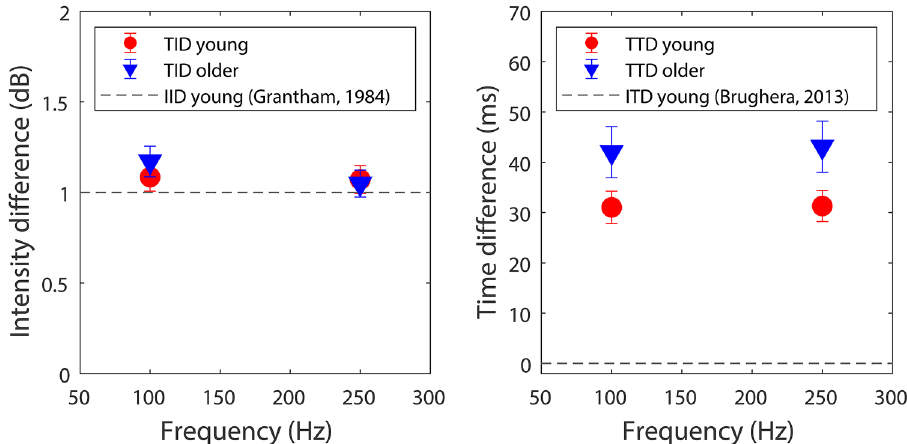
Figure 1. Tactile intensity (TID; left panel) and time (TTD; right panel) difference discrimination thresholds across the wrists for young (red circles) and older (blue downward facing triangles) participants. Thresholds are shown for both 100- and 250-Hz sinusoidal stimuli. For comparison, dashed grey lines show thresholds for interaural intensity (IID) and time (ITD) difference discrimination in young adults. Error bars show the standard error of the mean. This figure was generated using MATLAB R2019a (http://www.mathw orks.com/ produ cts/matla